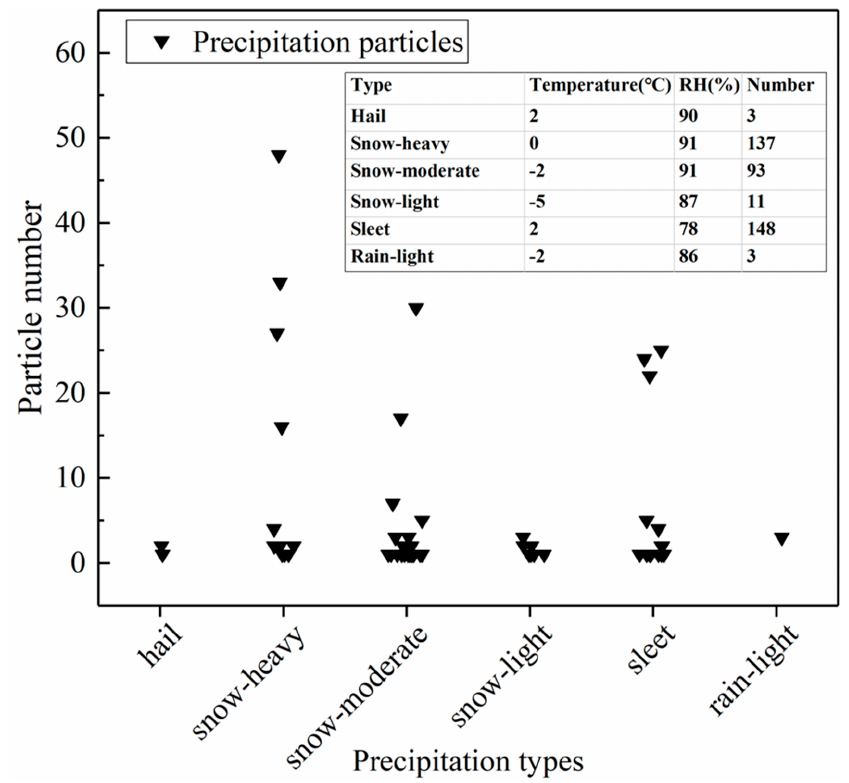
Figure 4. Statistics of meteorological conditions observed for precipitation particles >10 mm in diameter.